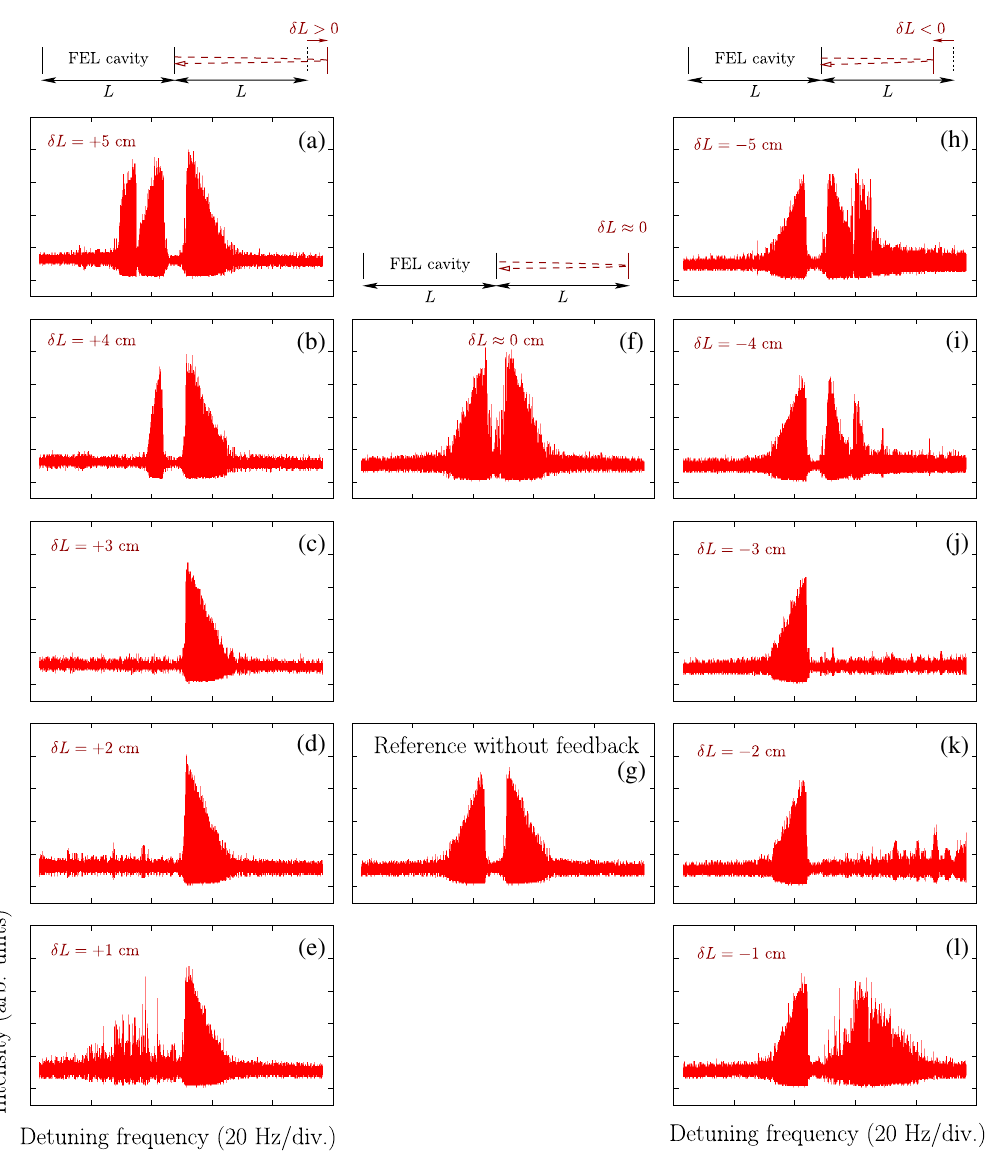
FIG. 4. Systematic investigation of bifurcation diagrams (detuning curves) of the free-electron laser versus feedback mirror position (cid:2)L (feedback delay is (cid:2)(cid:1) ¼ 2 (cid:2)L ). (a) (cid:2)L ¼ þ 5 cm ; (b) (cid:2)L ¼ þ 4 cm ; (c) (cid:2)L ¼ þ 3 cm ; (d) (cid:2)L ¼ þ 2 cm ; (e) (cid:2)L ¼ þ 1 cm ; (f) (cid:2)L (cid:3) 0 cm (defined as the value of (cid:2)L giving an approximately symmetric diagram); (g) reference curve without feedback; (h) (cid:2)L ¼ (cid:1) 5 cm ; (i) (cid:2)L ¼ (cid:1) 4 cm ; (j) (cid:2)L ¼ (cid:1) 3 cm ; (k) (cid:2)L ¼ (cid:1) 2 cm ; (l) (cid:2)L ¼ (cid:1) 1 cm